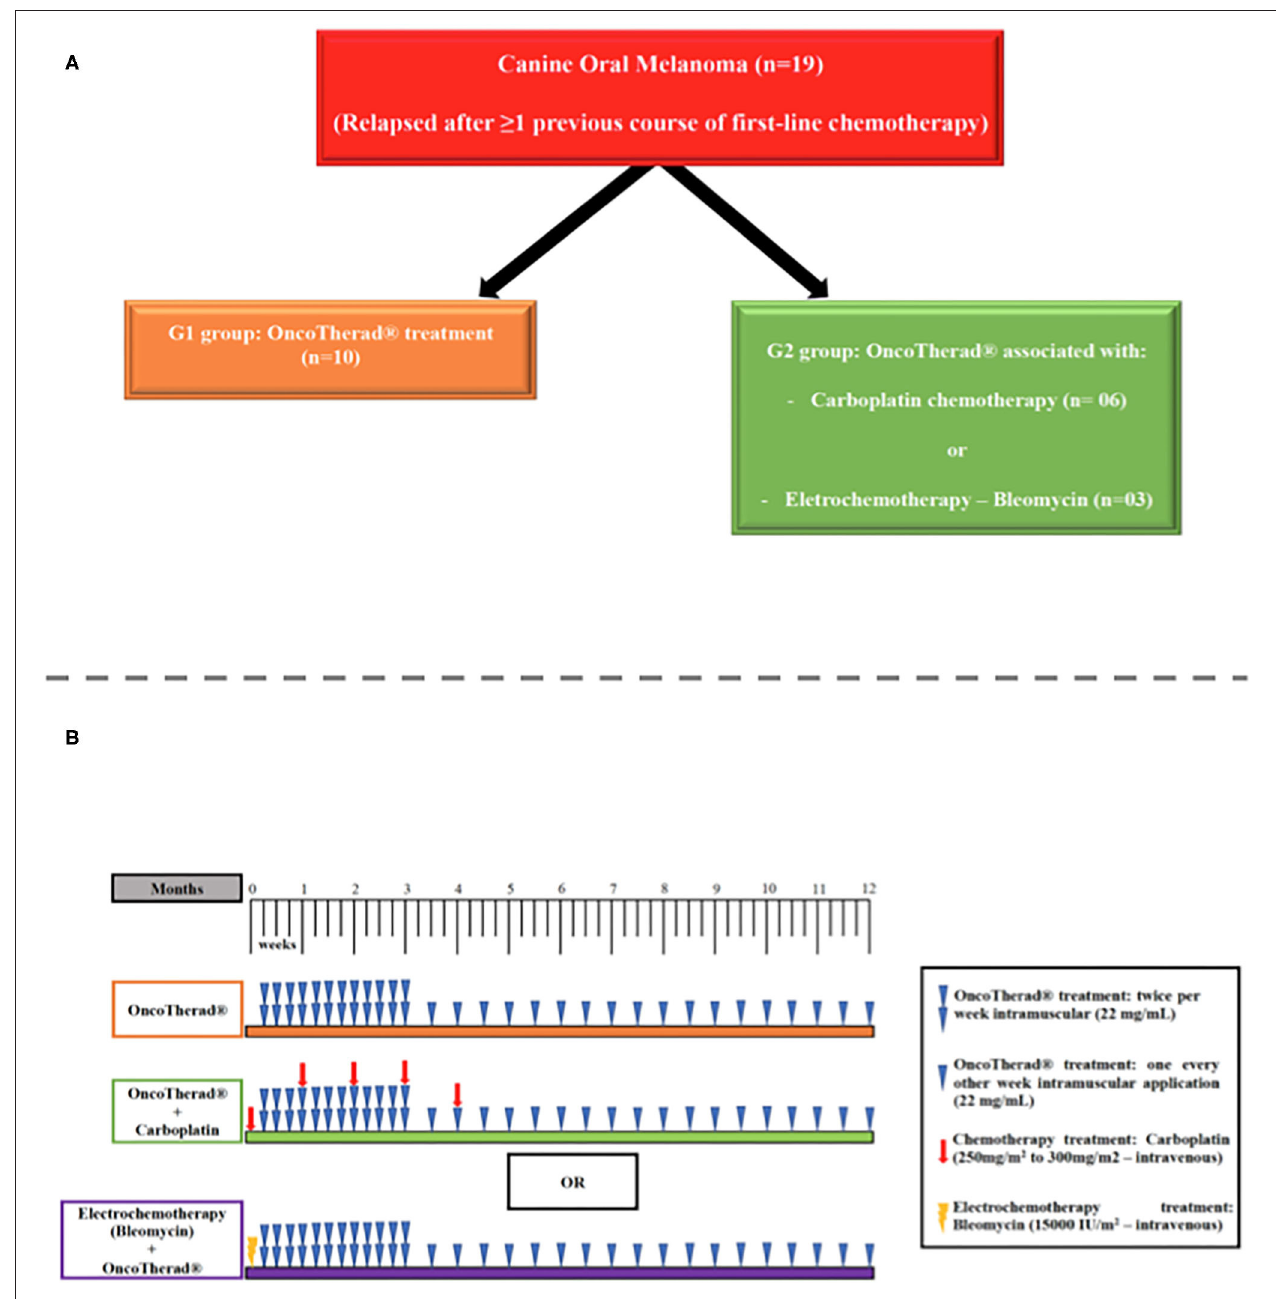
FIGURE 5 | (A) Scheme of the group division (OncoTherad ® treatment associated or not with chemotherapy or electrochemotherapy). (B) Timeline of the treatments (OncoTherad ® treatment associated or not with chemotherapy or electrochemotherapy).